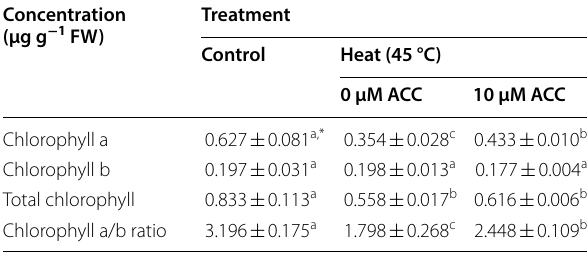
The values are presented as mean standard deviation based on six biologically ± independent experiments *Different letters indicate significant difference between the treatments assessed using the LSD post hoc test ( P <